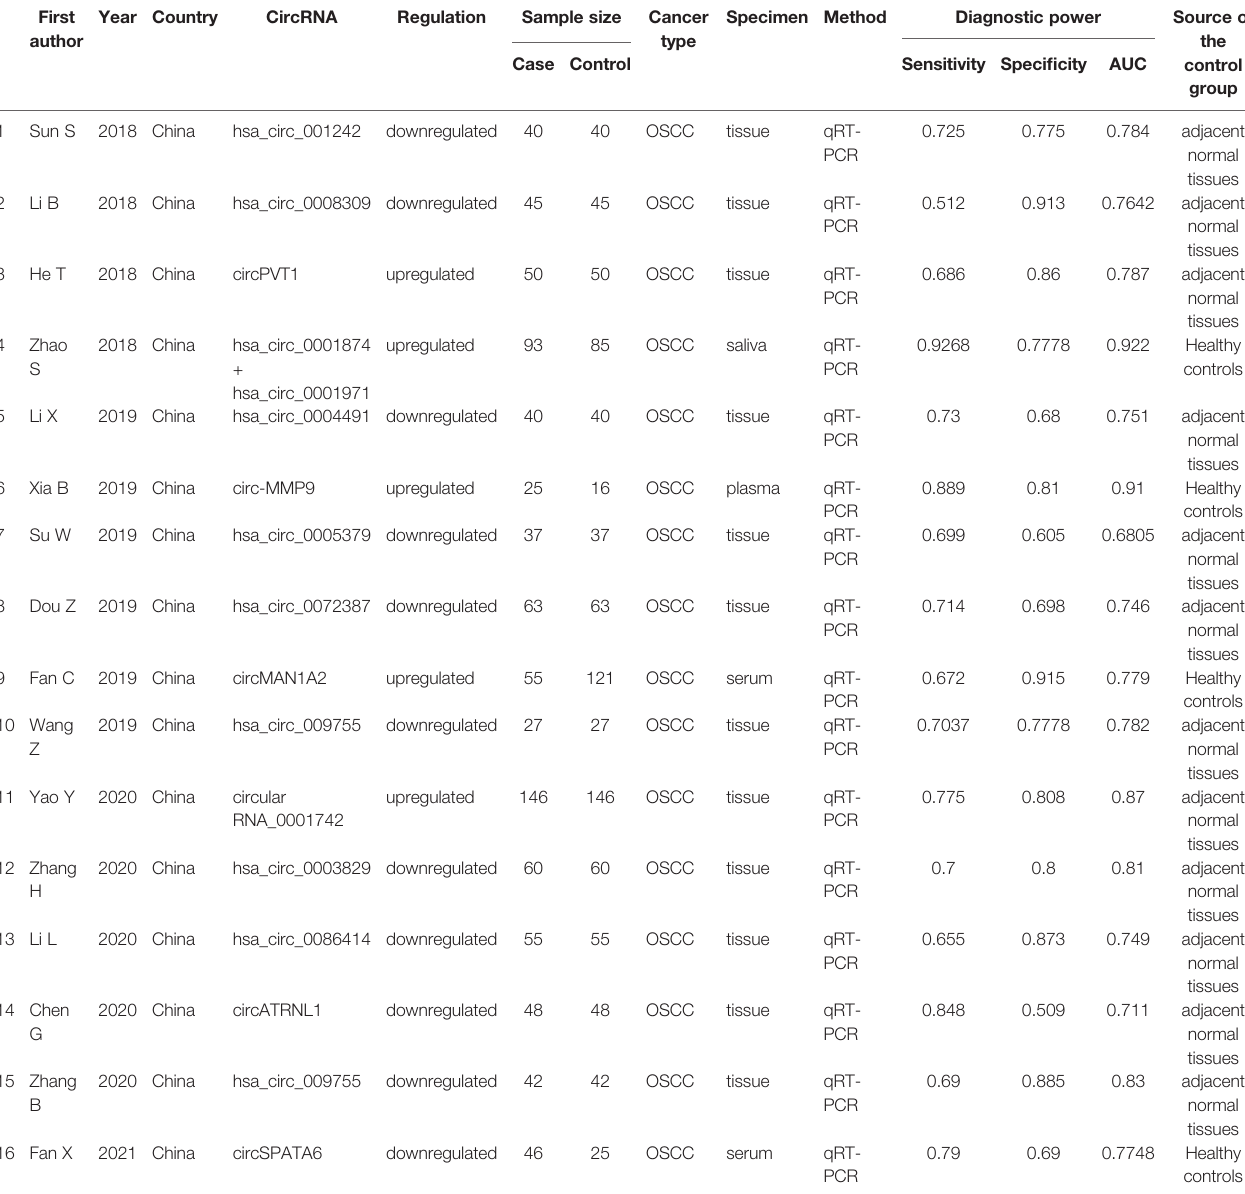
TABLE 1 | Main characteristics of 16 studies included in the